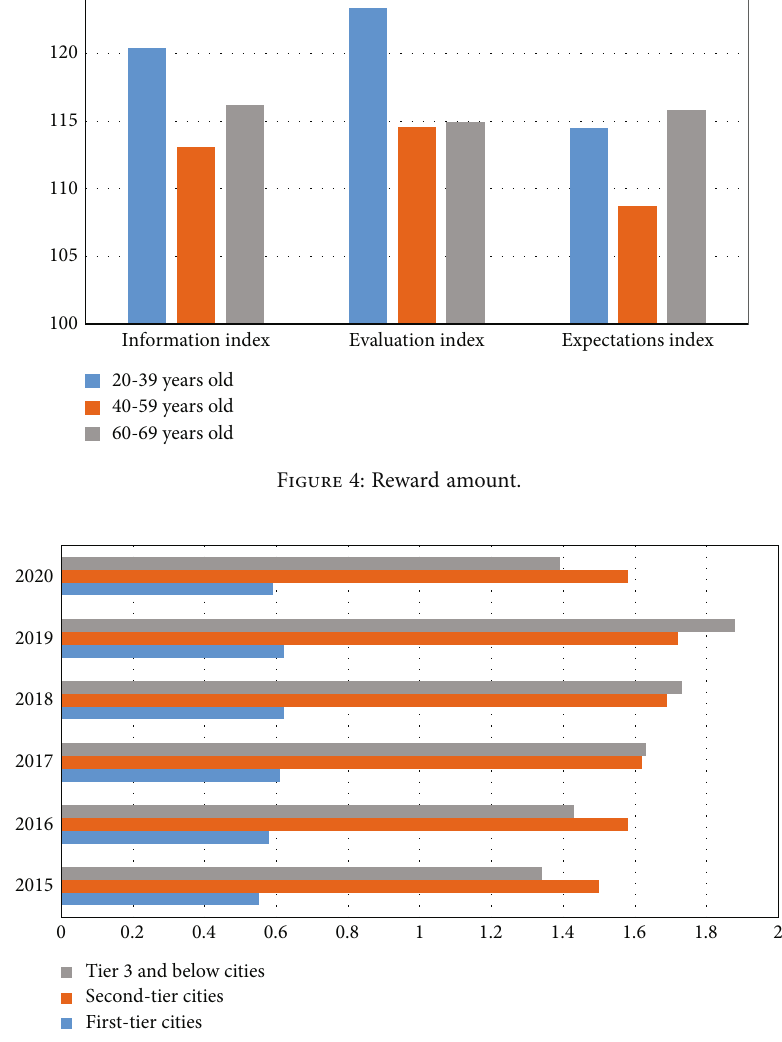
Figure 5: Distribution in fi rst-tier cities, second-tier cities, and third-tier cities from 2015 to